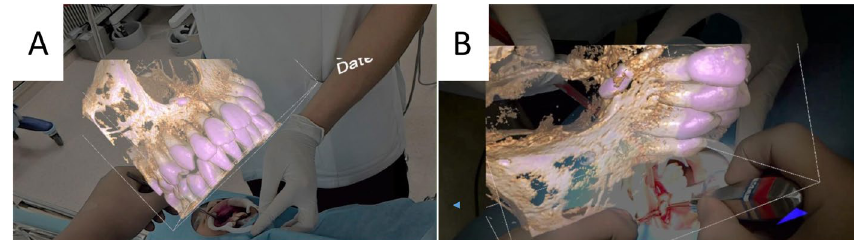
Fig. 4 Case 2. A , B Intraoperative view using MR technology